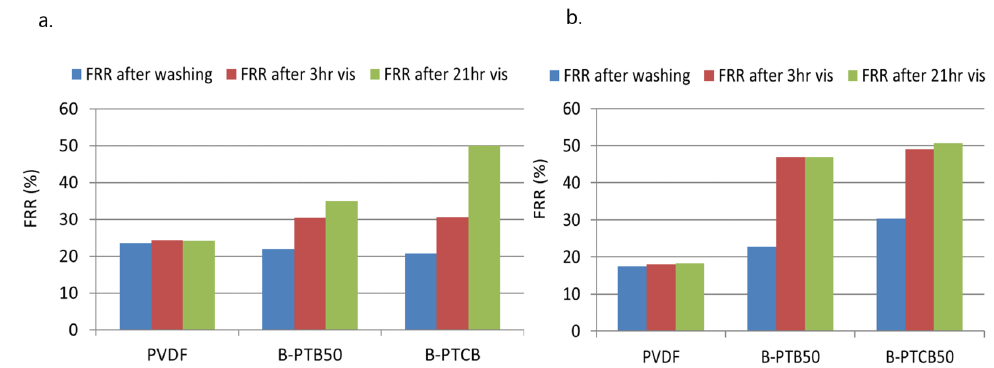
Figure 6. Rejection performance of pristine PVDF, PTB50, and PTCB50 membranes during real dairy wastewater filtration, using unfiltered ( a ) or pre-filtered (0.2 µm filter paper) wastewater ( b ).